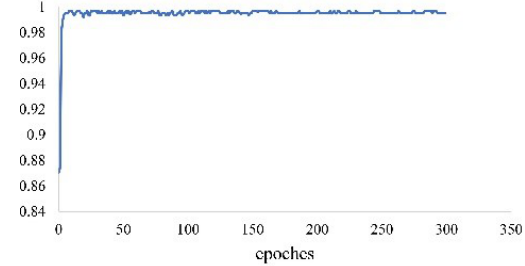
Figure 11. Curve of precision and recall.